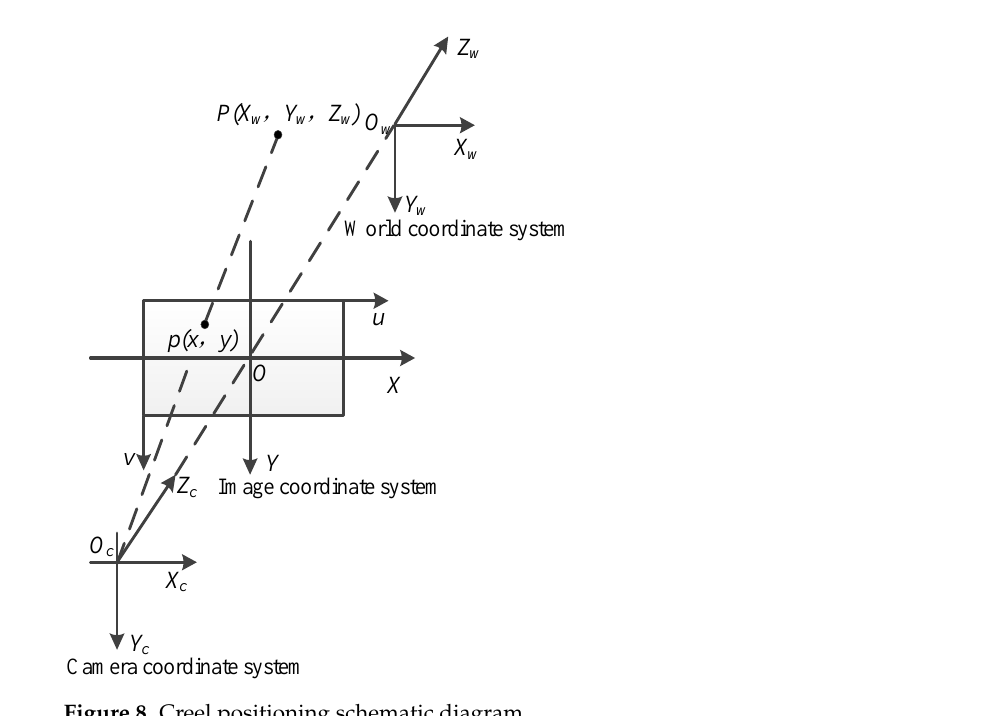
Figure 8. Creel positioning schematic diagram.